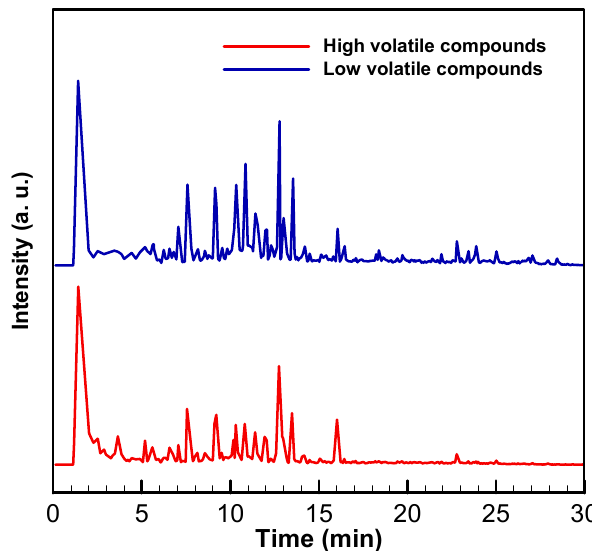
Figure A2. GC/MS spectra of high and low volatility compounds at 300 °C in vacuum systems.